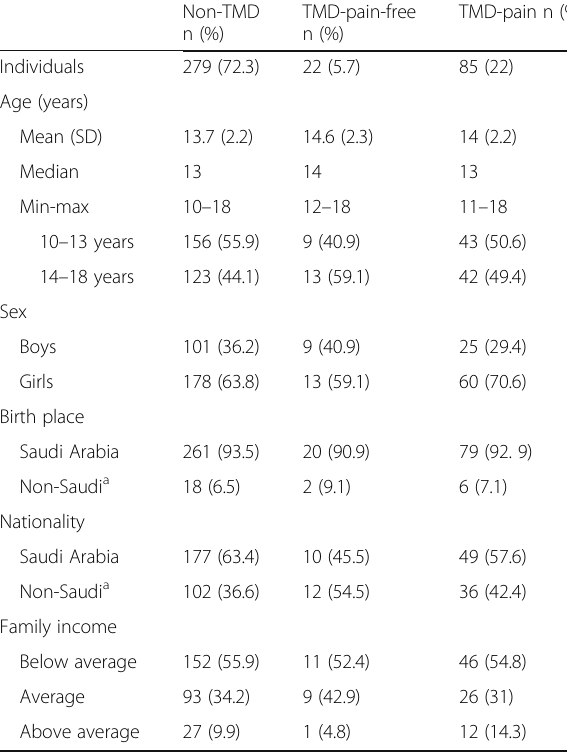
Table 1 Patient characteristics for 386 participants in Jeddah, Table 2 The parents ’ reports of children ’ s physical activities and social competence in 386 randomly selected children